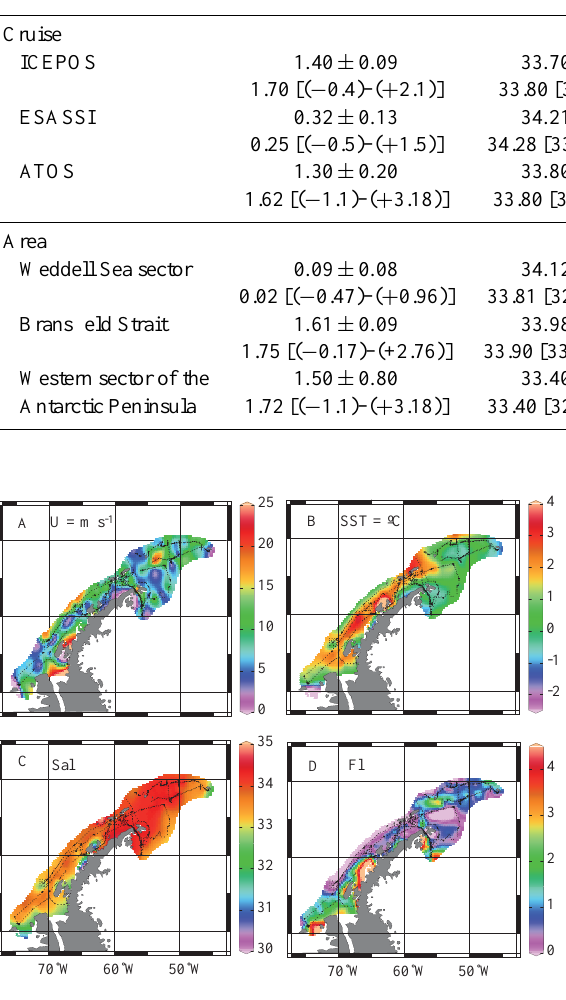
Figure 2. The distribution of shipboard continuous measurements (all three cruises combined) of wind speed ( U , ms − 1 , A ), sea- surface temperature (SST, ◦ C; B ), salinity (Sal, C ) and fluorescence (Fl, D